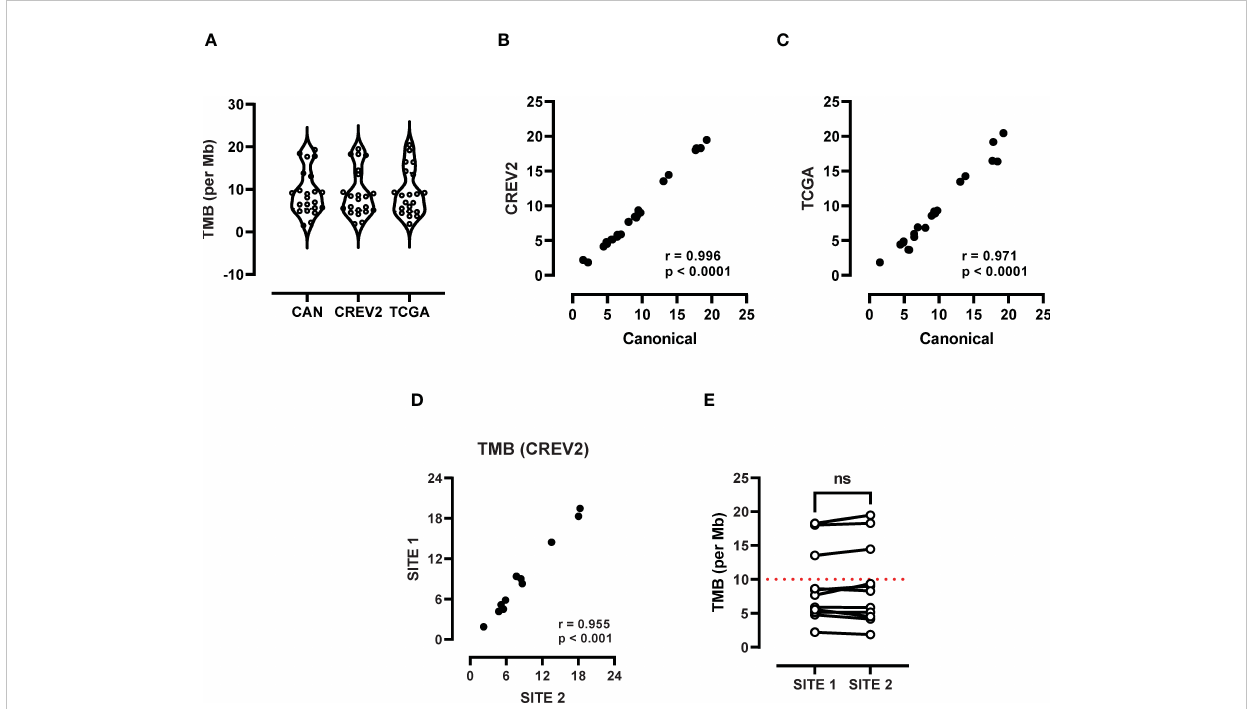
FIGURE 1 Assessment of TMB heterogeneity using whole exome sequencing. (A) TMB scores derived from three databases including TCGA, canonical and CREV2 were used to determine the number of exonic mutations per Mb. (B) Spearman correlation analysis was performed to investigate the association between TMB values derived from (B) TCGA versus the canonical database and the (C) TCGA and CREV2 databases. (D) TMB scores at the primary (site 1) and metastatic site (site 2) were compared by Spearman analysis and (E) paired analysis was performed between site 1 and site 2. ns, not signi fi